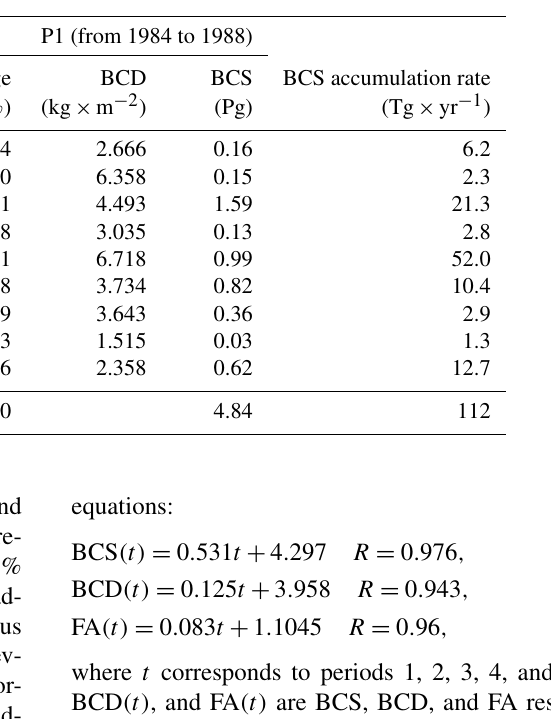
Table 2. BCS and BCD of the forests in the nine regions of China during the periods 2004–2008 and